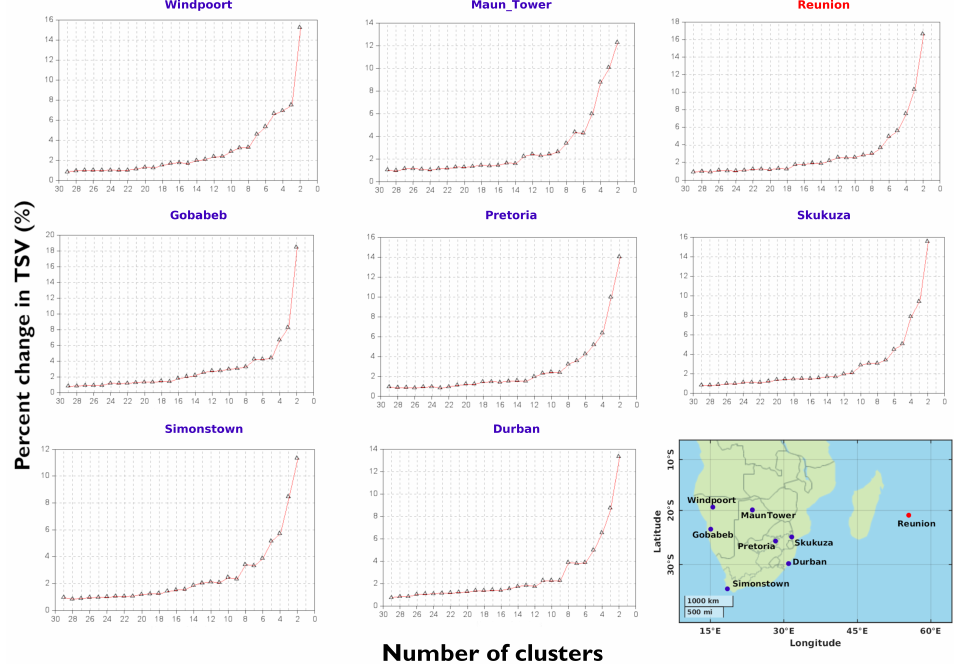
Figure A2. Number of clusters as a function of percent change in total spatial variation (TSV) over the eight sun photometer sites.